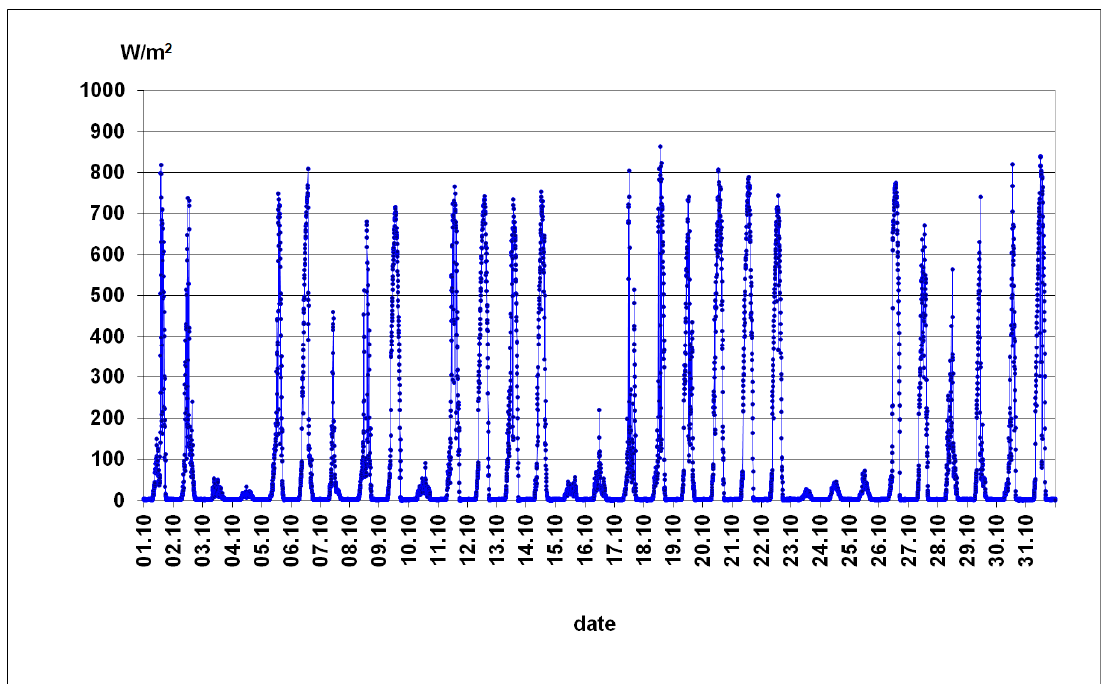
Figure 15. Graph of the global solar irradiance incident on the southern vertical plane in October. The energy gains from solar radiation collected during sunny days were used during